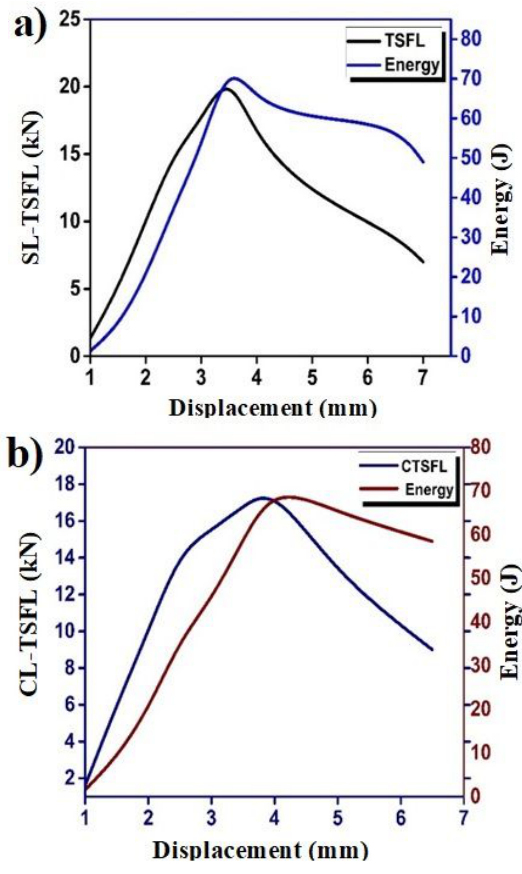
Figure 5: Failure energy of RSW AHSS-DP800 joints: a) SL-TSFL